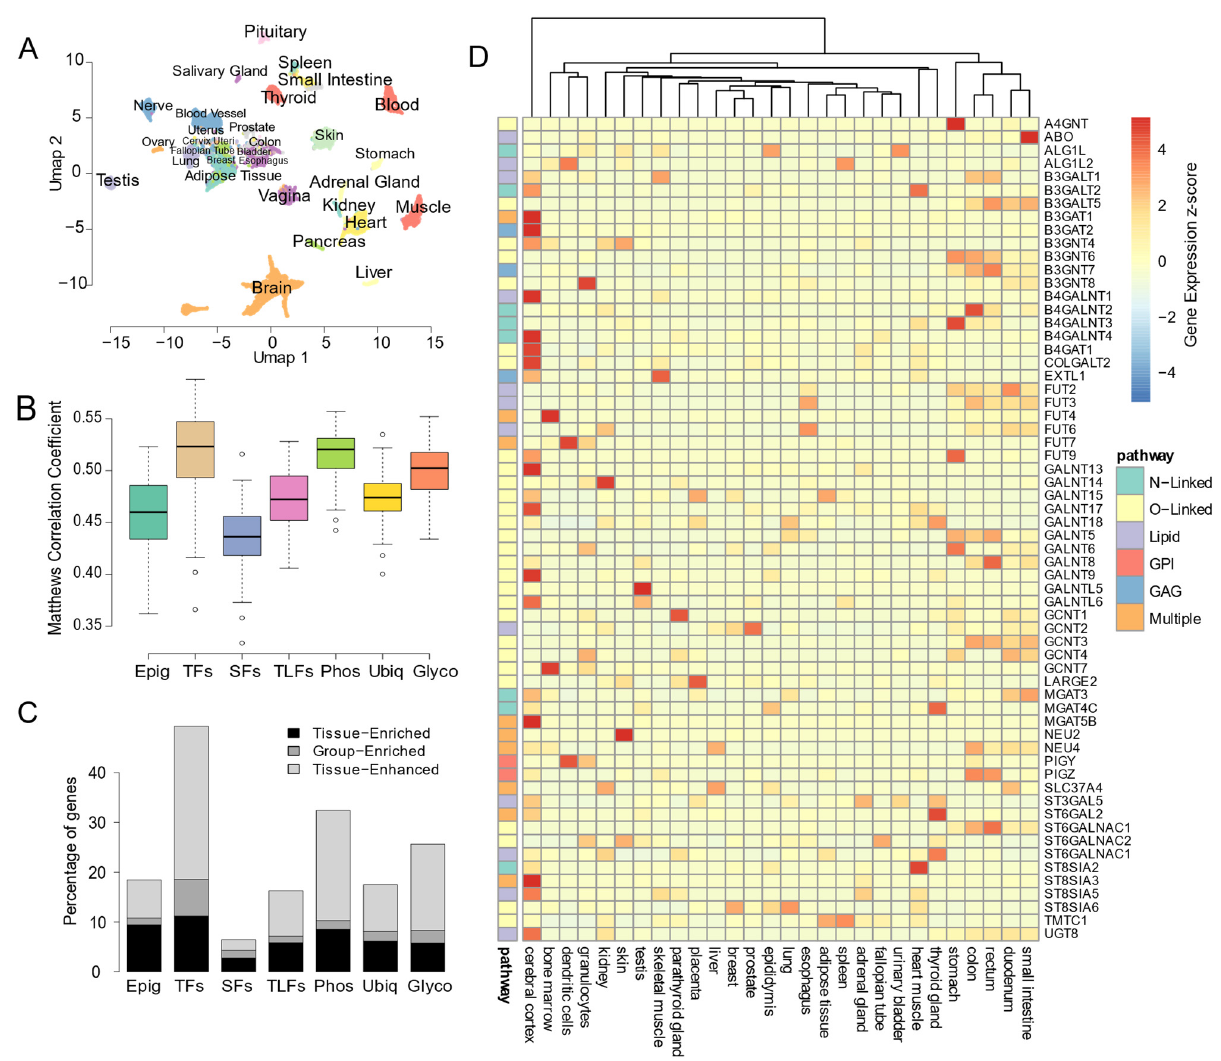
Figure 2. Glycosylation Factors show tissue-specific expression. ( A ) Uniform Manifold Approxima- tion and Projection (UMAP) representation, based on the gene expression profiles of glycosylation factors of GTEX samples, colored according to their tissue of origin. ( B ) Boxplot representation of the Matthews Correlation Coefficient (MCC) value for the classification of the tissue of each GTEX sample ( n = 100 random forest models using 30 randomly selected genes of each gene class). ( C ) Cumulative bar plot representation of the frequency of genes belonging to each gene class that show tissue-specific expression in protein atlas (colors represent degree of specificity as defined in TissueEnrich from the most specific Tissue-Enriched to the least specific Tissue-Enhanced). ( D ) Heatmap representation of the protein atlas gene expression of glycosylation factors displaying some degree of specificity (represented expression values are scaled z-scores). Only tissues with at least one gene with z-score > 2 are represented.